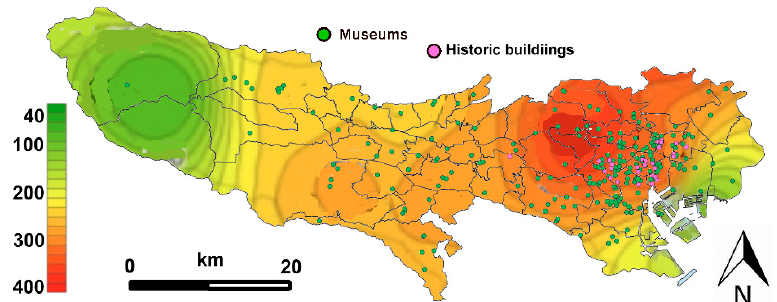
Figure 4. The total number of hours with temperatures above 30 °C averaged 2003–2007 over the Tokyo area. Note: Base map extracted from RealEstateJapan and JMA.